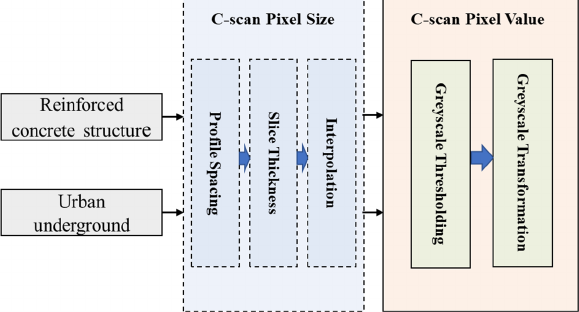
Figure 1. C-scan intensity normalisation scheme that continuous the 3D GPR imaging workflow.